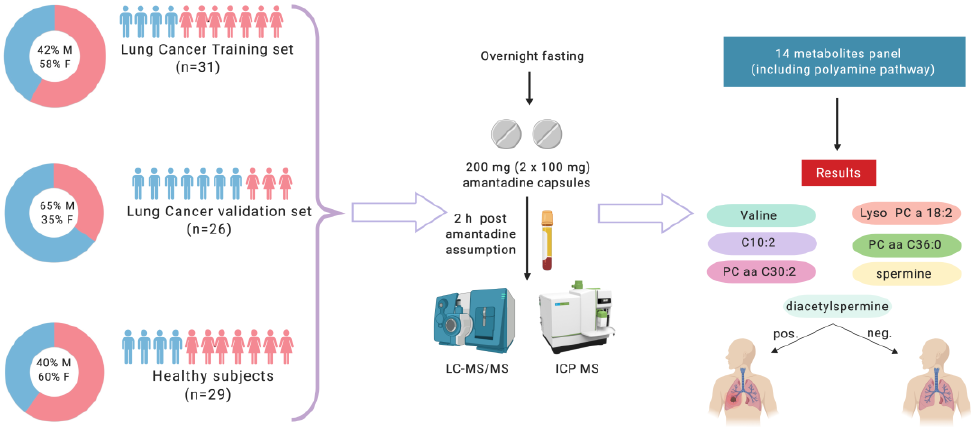
Figure 1. Study design. Credit: created with BioRender.